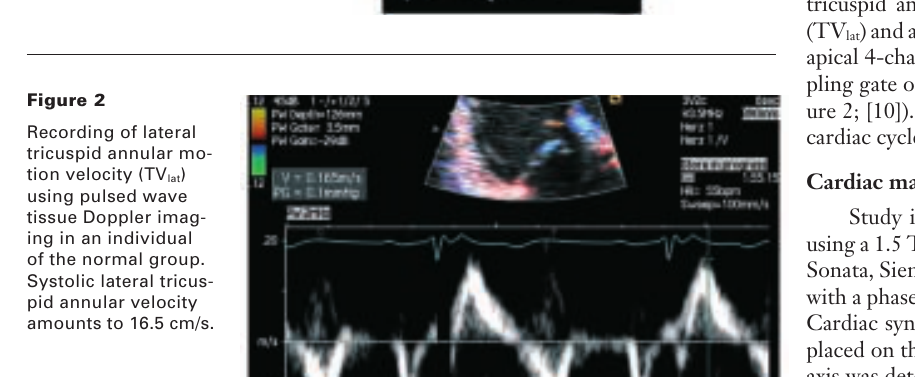
Two-dimensional echocardiographic images for the as- sessment of mono- and/or biplane right ventricular ejection fraction taken from the apical 4-chamber view (upper panels; diastole: left, systole: right), and from the subcostal view (lower panel). Abbrevia- tions: L = long axis; RV = right ventricular.